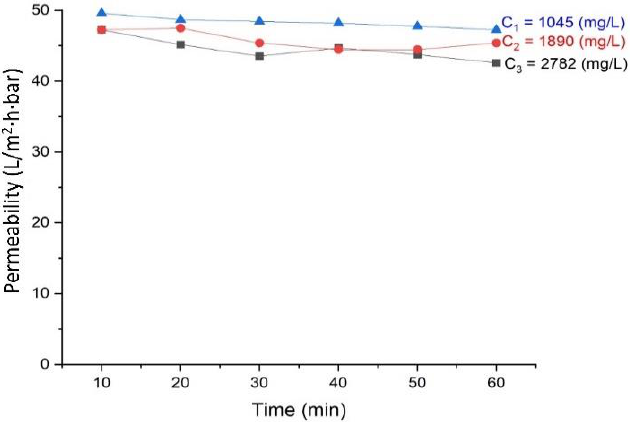
Figure 3. Effect of activated sludge concentration on permeability tested using reactor C.